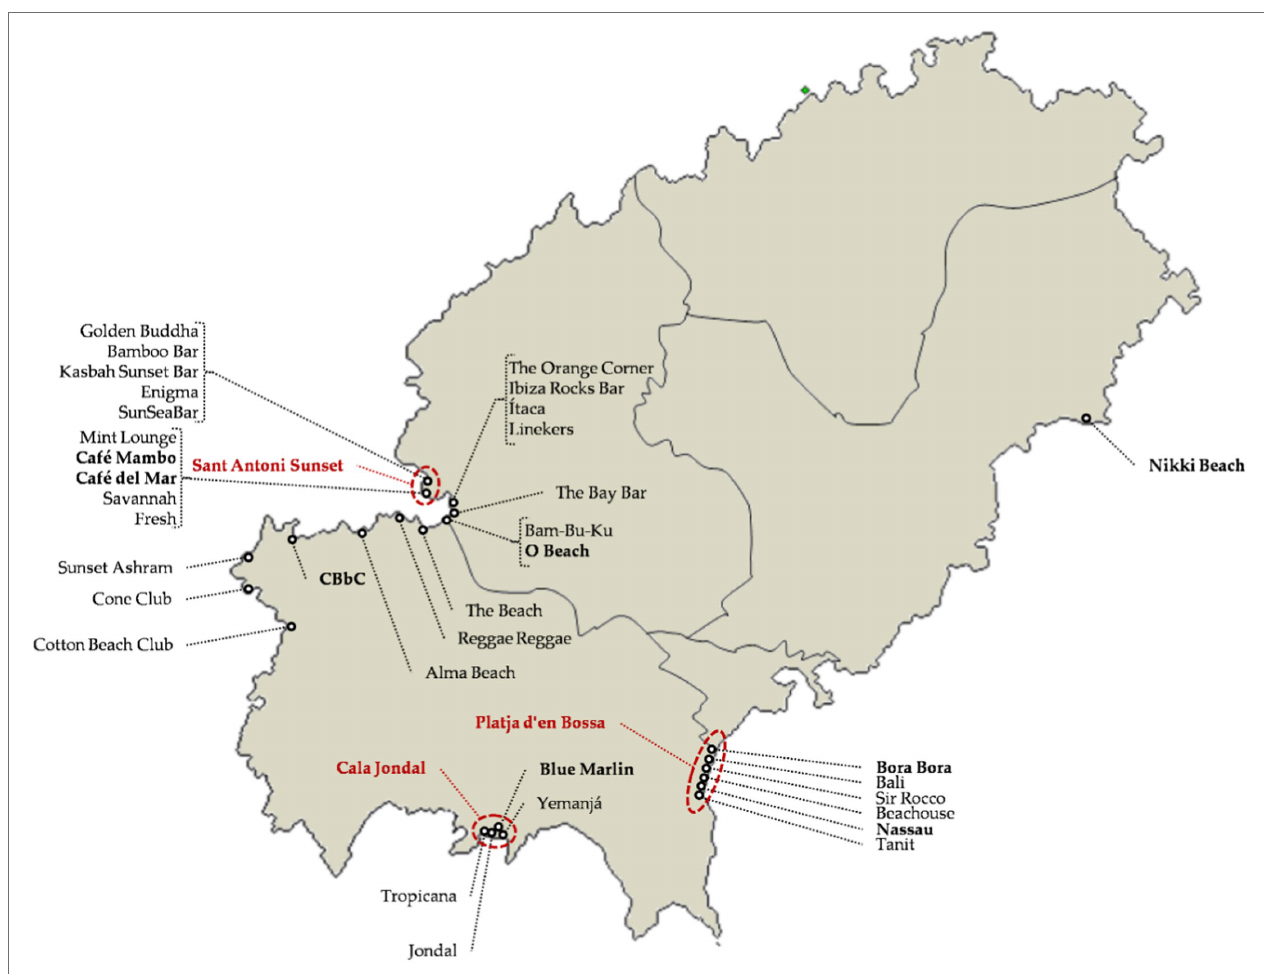
FIGURE 4 | Main beach clubs. Source: own